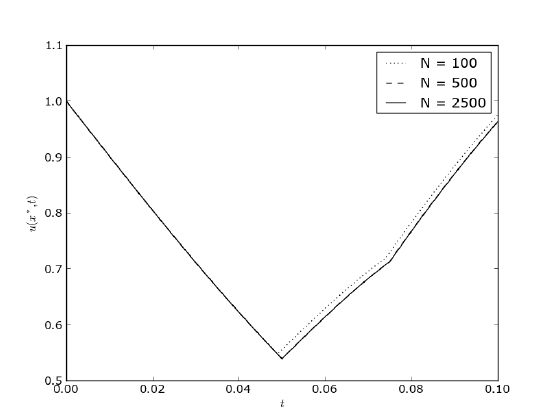
Figure 4. Approximate solution for various uniform time grids.